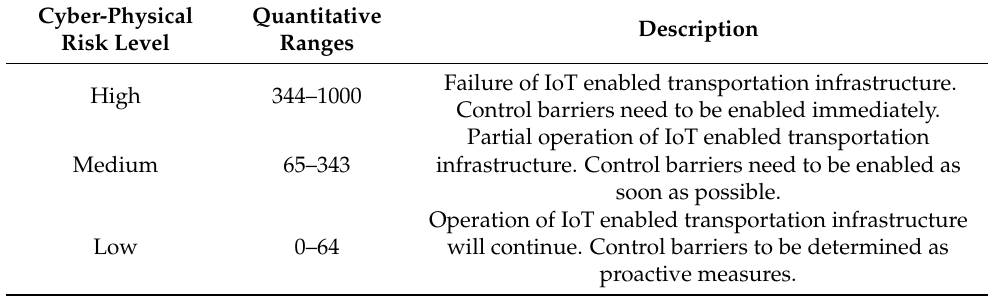
Table 2. Cyber-physical risk